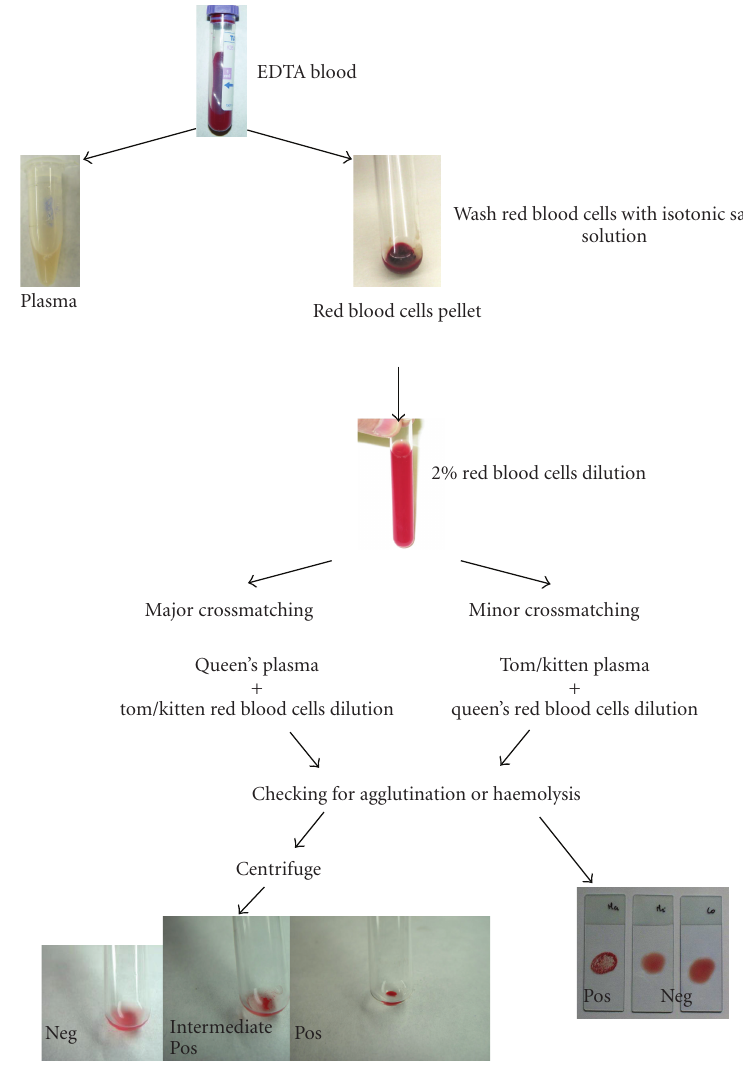
starts form its own anti-B alloantibodies soon after birth, and maternal antibodies from colostrum start to